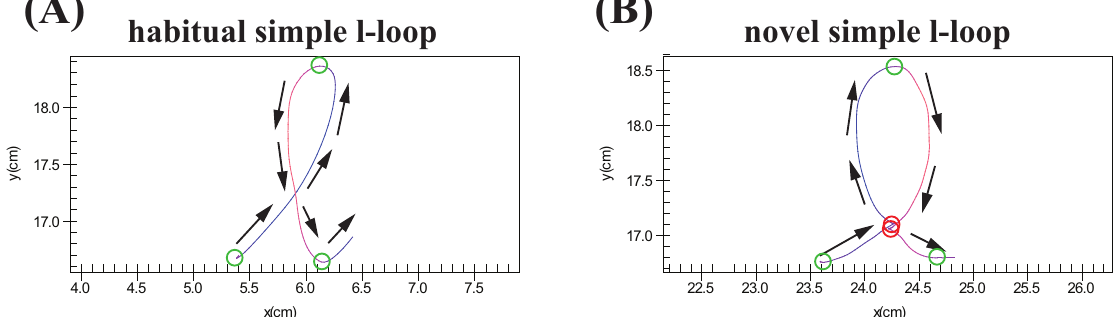
Figure 2. Exampleof ink traces of simple handwritten l-loops drawn with ( A ) the habitual motor plan and ( B ) a novel motor plan. Arrows indicate the directions followed by the pen tip for drawing the trace. Green circles indicate the segmentation points that appear when drawing the l-loop using both the habitual and the novel motor plan and red circles indicate the additional segmentation points that appear when drawing the l-loop using the novel motor plan. Different strokes have been indicated using different